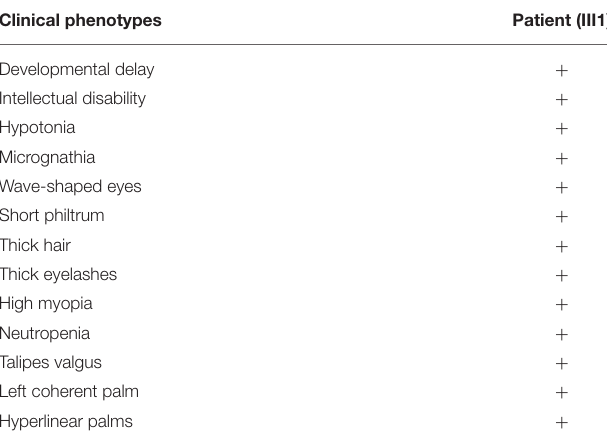
TABLE 1 | Summary of clinical findings of the